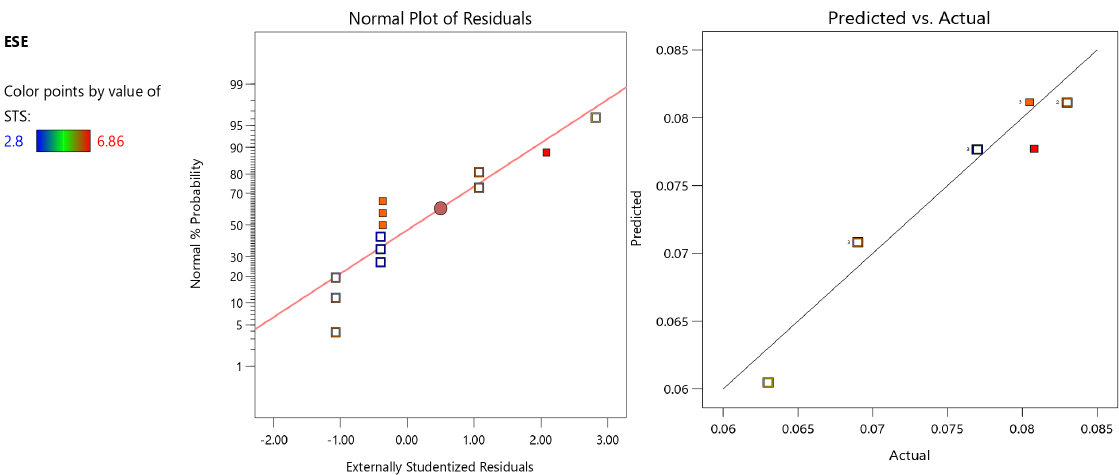
Figure 20. Normal plot for residuals, and actual vs. predicted values for eco-strength efficiency.